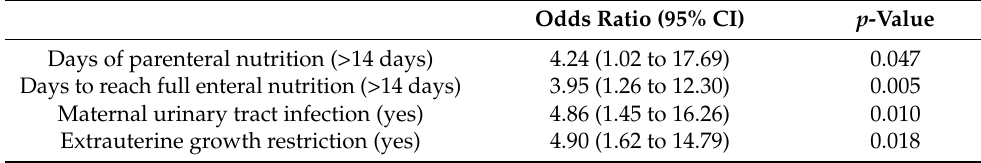
Table 4. Variables included in the final binary logistic regression model for late-onset